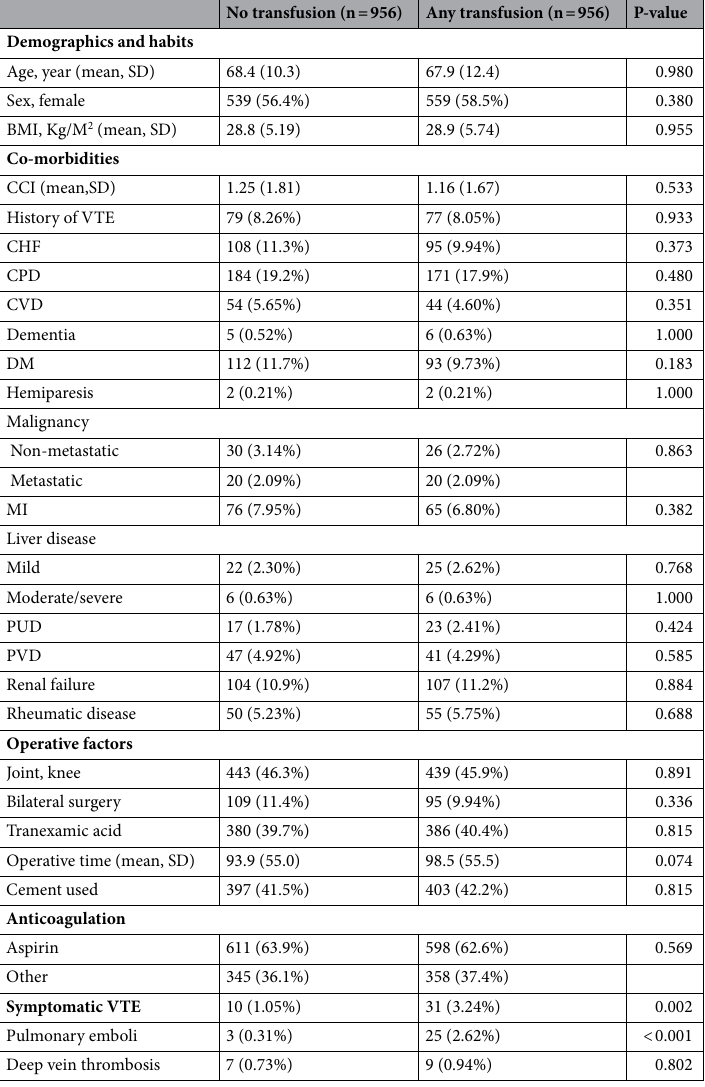
Table 4. Patient characteristics, comorbidities, operative factors and type of VTE prophylaxis for the matched primary TJA cohort and VTE rates. BMI Body Mass Index, Kg kilogram, M meter, CCI Charlson